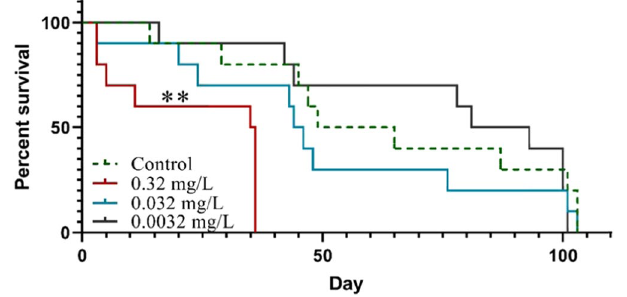
Figure 2. Survival of Daphnia magna exposed to different concentrations of 53 nm PS-NH 2 throughout their life-time. Asterisk indicates significant difference compared to the control group estimated over the whole study period, ** p < 0.01.